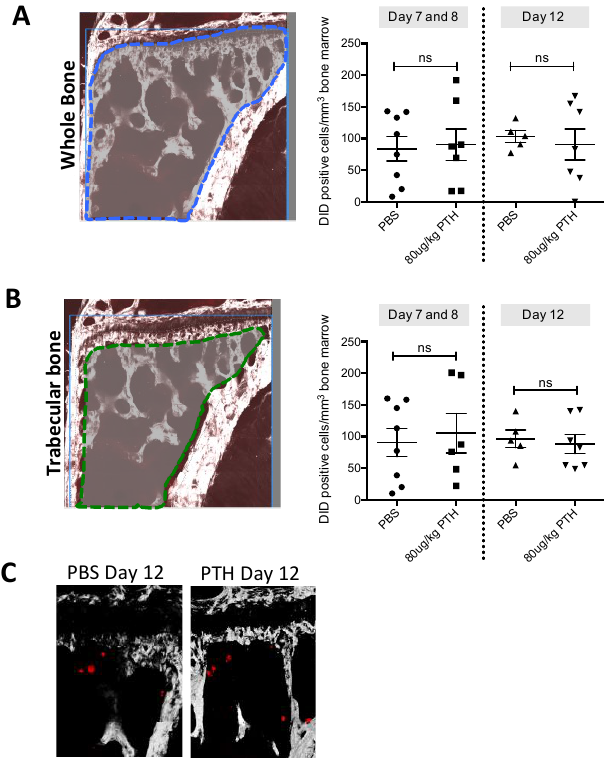
Figure 5. PTH pre-treatment does not alter tumour cell seeding to long bones in vivo. Twelve-week-old female BALB/c nude mice were treated with 80 μg/kg PTH or PBS before injection of DiD-labelled tumour cells. Animals were culled on day 7/8 and 12 and tibias were prepared for two-photon microscopy. ( A ) A stack area of 2104 μm × 2525 μm below the growth plate and 70 μm depth was visualized using a 633 nm laser to detect DiD stained tumour cells (referred to as DiD-positive events). ( B ) The same analysis as in A but including only the trabecular bone area. Data is presented as mean ± SEM and statistical analysis was performed using t -test. No significant difference was detected. A minimum of n = 5 tibias per group were analyzed. ( C ) Example images of DiD-positive events (red) in the tibia imaged by multiphoton microscopy (bone: white, imaged using second harmonic